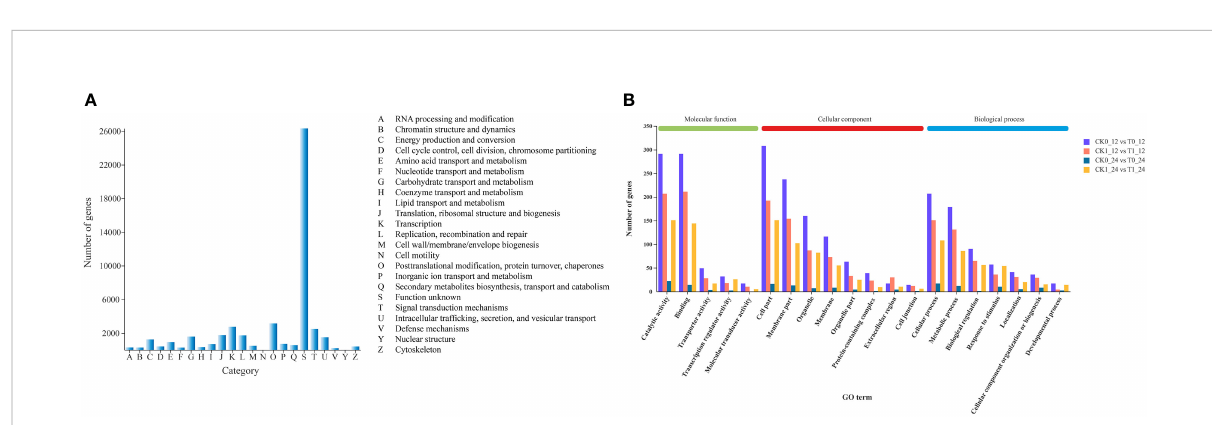
Figure 8 listed the DEGs of the samples in CK1 and T1 groups that are related to the plant hormone signal